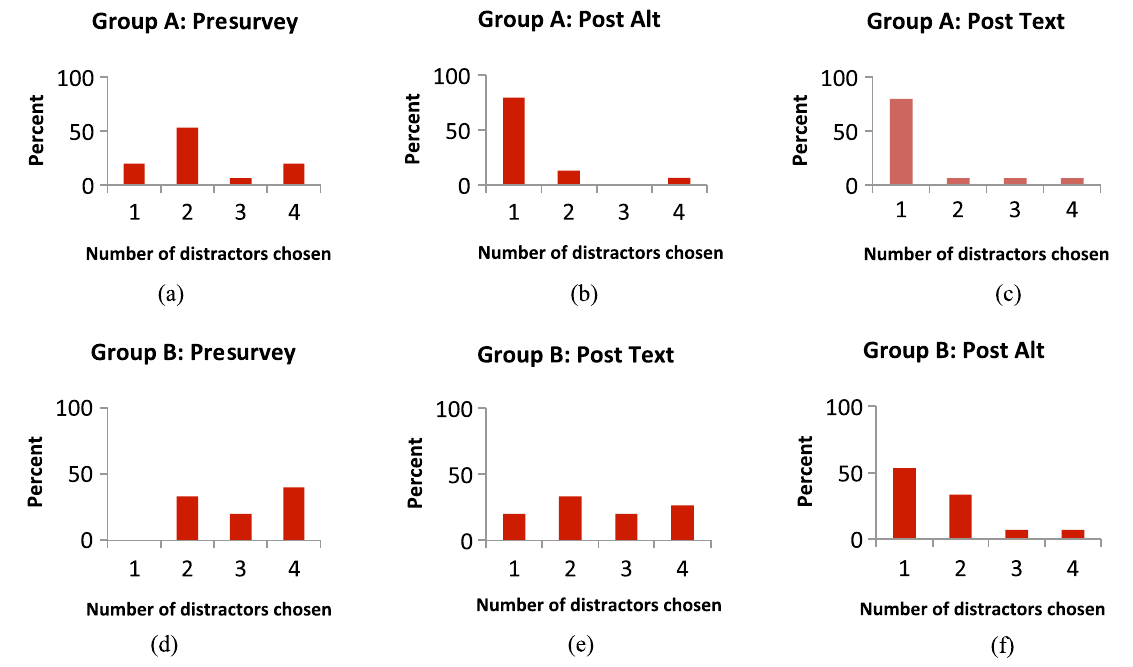
FIG. 5. The percentage of students who chose either one, two, three, or four distractors in questions 9 – 14 in the Presurvey and in questions 10 – 15 in the Post Alt and Post Text surveys for group A and group